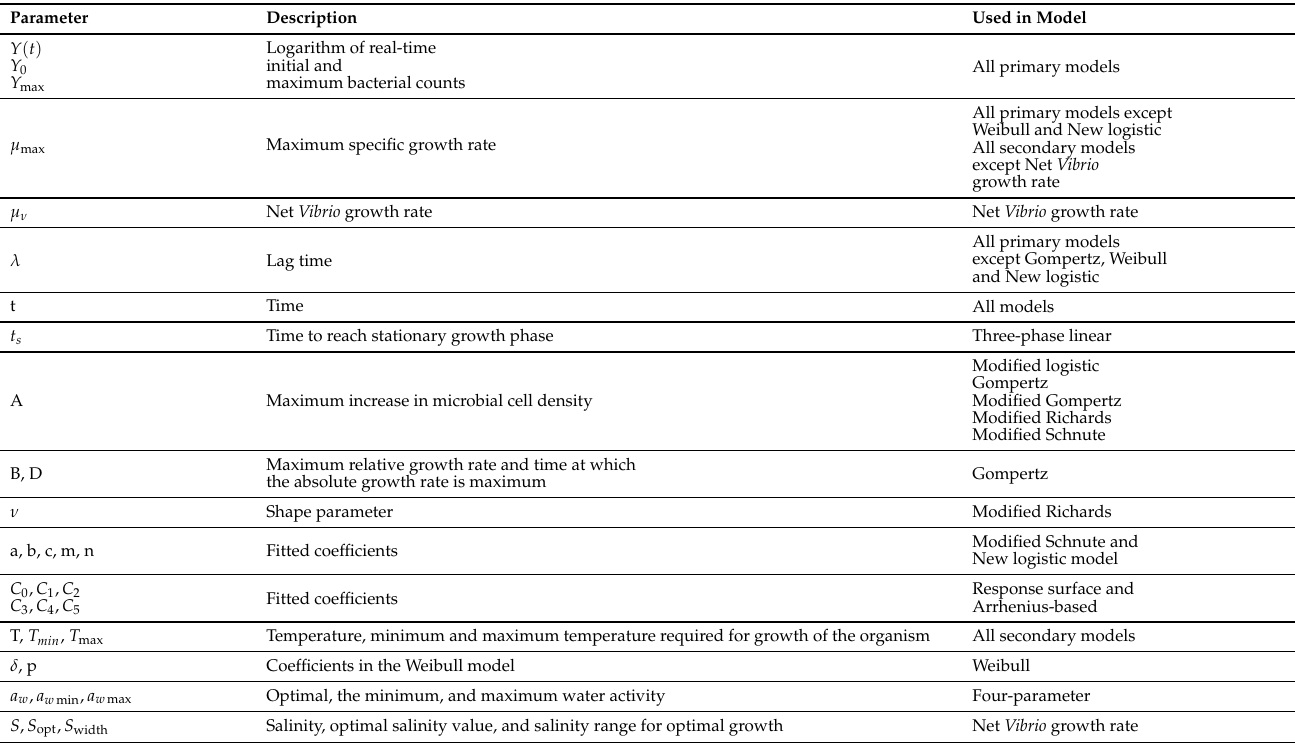
Table 3. Parameters used in Vibrio spp. primary and secondary models. Last column lists models using the particular